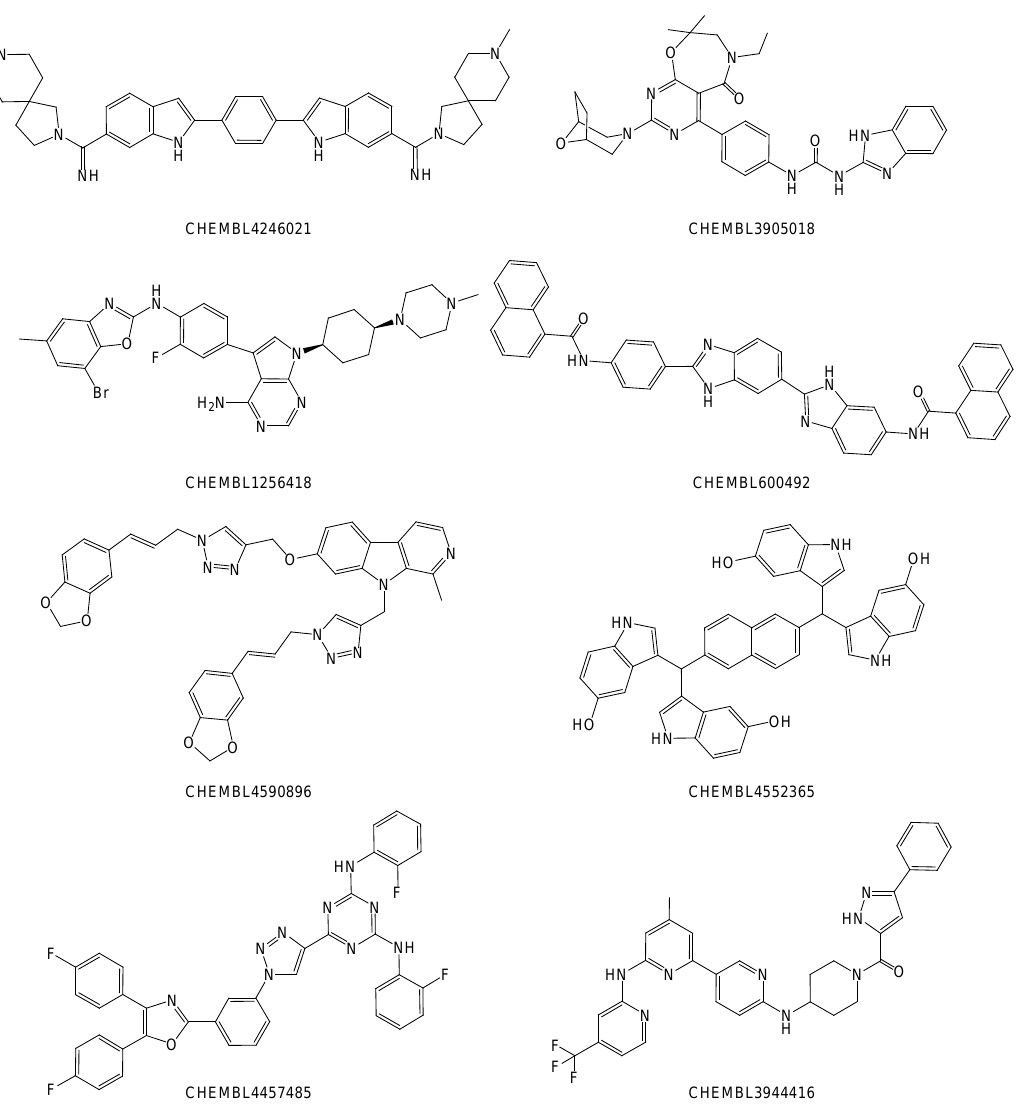
Figure 4. Planar structures of the top-scoring eight ( ≤−13 kcal·mol −1 ) bioactive compounds obtained from the AutoDock Vina docking simulations.